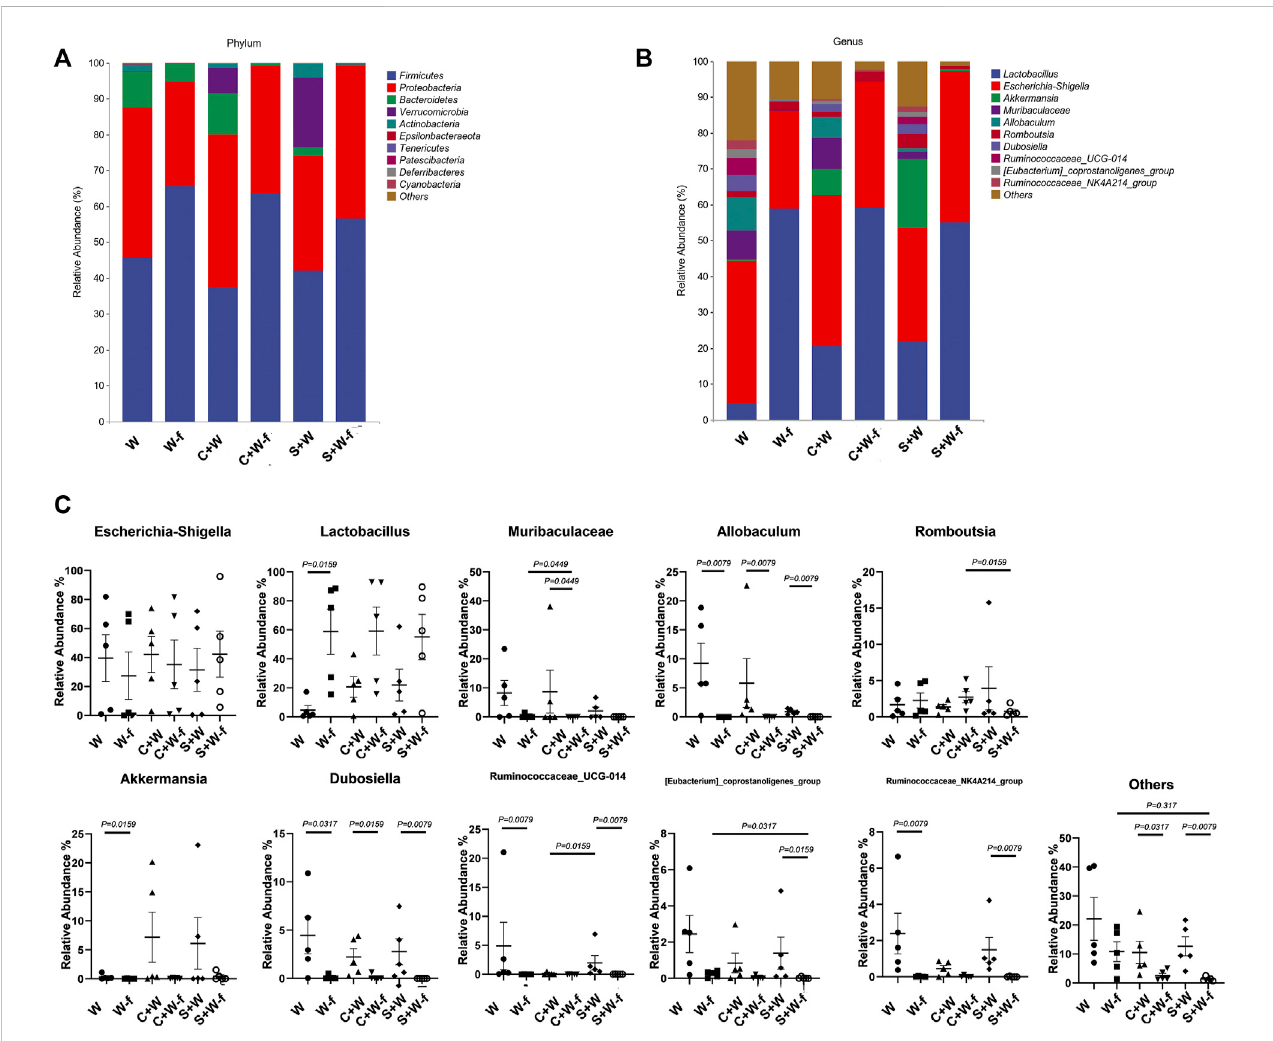
FIGURE 3 The relative abundance of gut microbiota compositions (A) At the phylum level and (B) genus level; (C) signi fi cant bacteria on the relative abundance at the genus level. W: MCAO rats with oral administration of warfarin; W-f: pseudo germ-free MCAO rats with oral administration of warfarin; C + W: MCAO rats with oral co-administration of warfarin and Chuanxiong Rhizoma; C + W-f: pseudo germ-free MCAO rats with oral co-administration of warfarin and Chuanxiong Rhizoma. S+W:MCAOratswithoralco-administrationofwarfarinandsenkyunolideI;S+W-f:pseudo germ-freeMCAOratswithoralco- administration of warfarin and senkyunolide